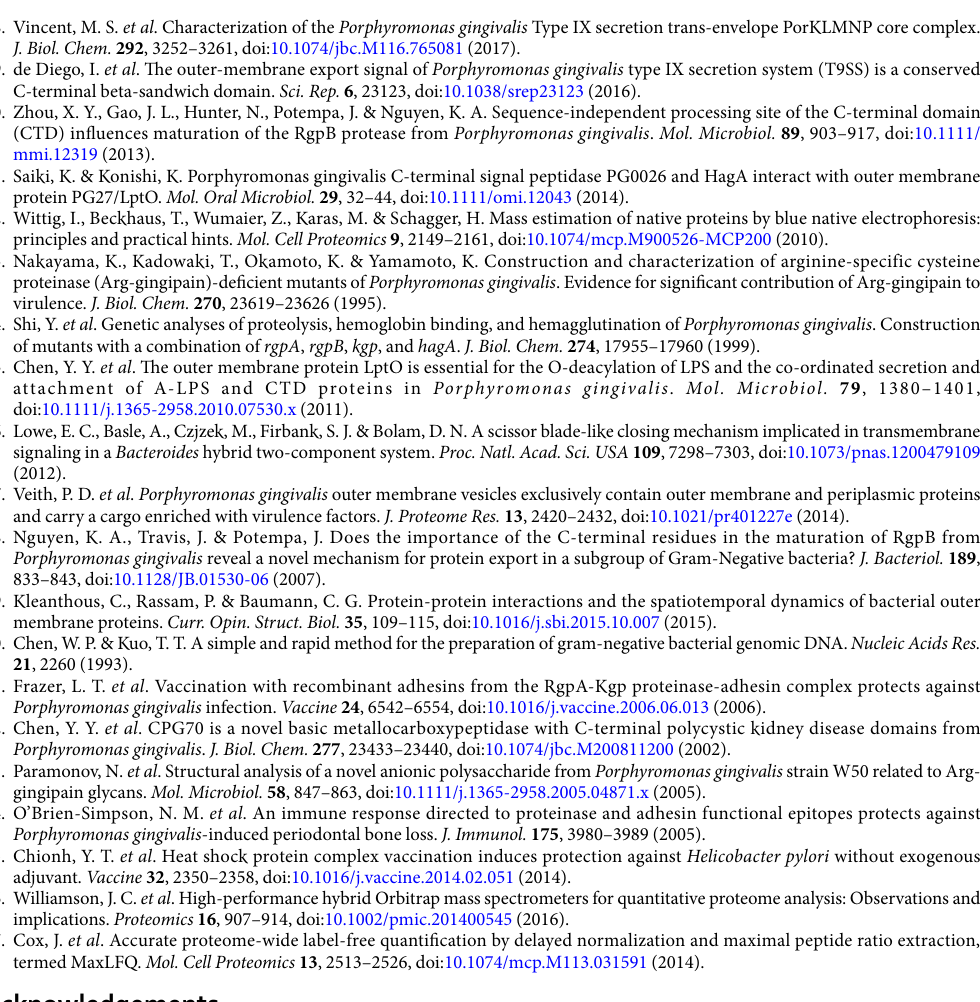
Fig. 9, D.G.G. produced Supplementary Fig. S5B, P.D.V., M.D.G. and D.C. produced Fig. 8 and Supplementary Tables S1,